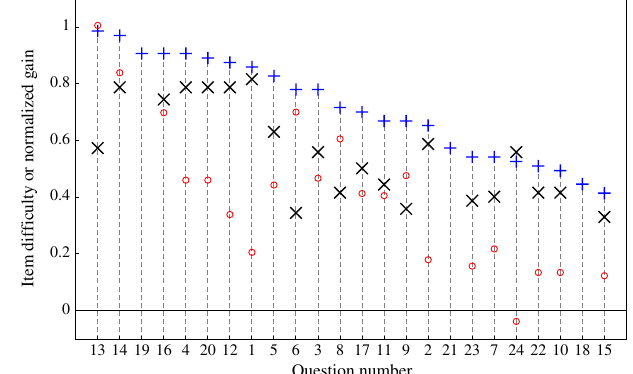
FIG. 1 (color online). RCI results by question for the Physics 2 class: the post-test item difficulties (blue þ ), pre-test item difficulties (black (cid:5) ), and the normalized gain (red (cid:6) ). The question number ordering is by postinstruction item difficulty.